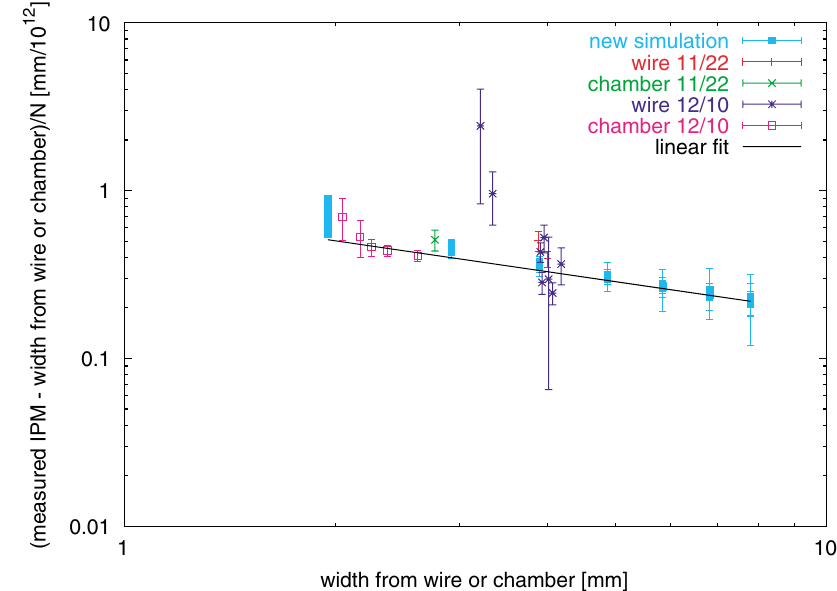
FIG. 6. (Color) Comparison of our linear parametrization with the data and simulation. The linear parametrization predicts a linear relationship between the quantities plotted. The simulation has been normalized to match the